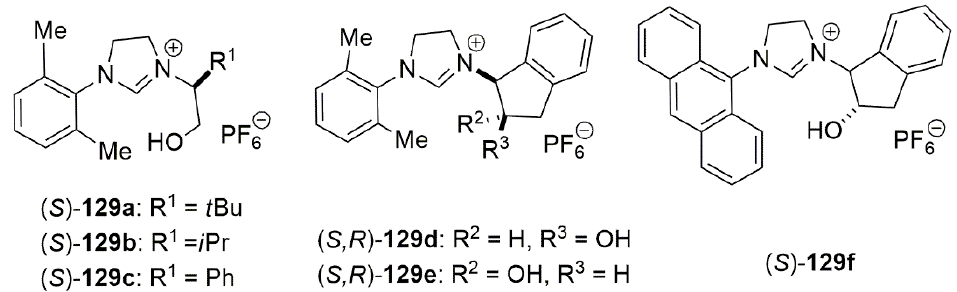
Figure 11. Chiral mono ‐ and bidentate NHC ligands [156].